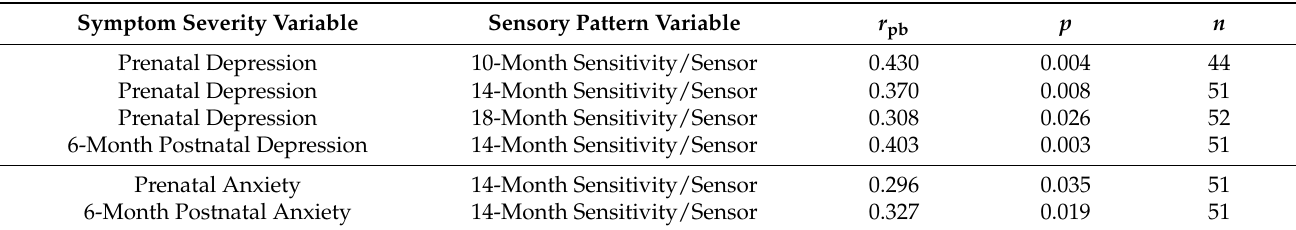
Table 2. Correlations between Depression and Anxiety Symptom Severity and Sensory Patterns; the p -value was set at 0.05. Symptom Severity Variable Sensory Pattern